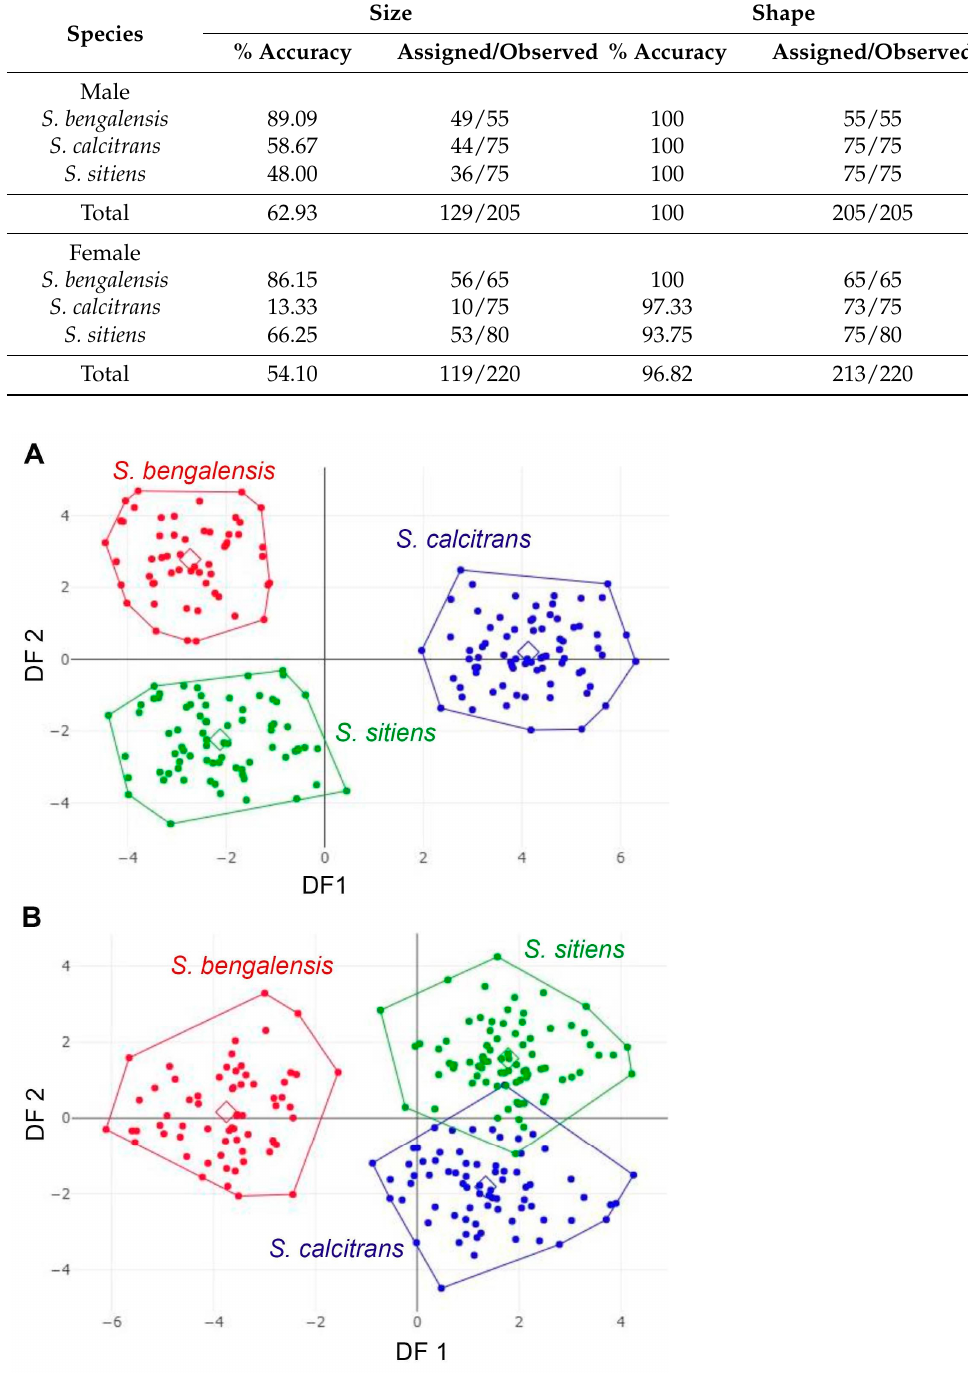
Figure 9. Factor maps of discriminant factors (DFs) showing wing shape variation in male ( A ) and female ( B ) Stomoxys bengalensis , S. calcitrans , and S. sitiens . For males, the two DFs represent 100% of the total discriminant space: 72% for DF1 and 28% for DF2. However, for females, the two DFs represent 100% of the total discriminant space: 74% for DF1 and 26% for DF2. Table 3. Mahalanobis distances (below diagonal) and p -values (above diagonal) in the wing shape of male and female Stomoxys bengalensis , S. calcitrans , and S. sitiens.